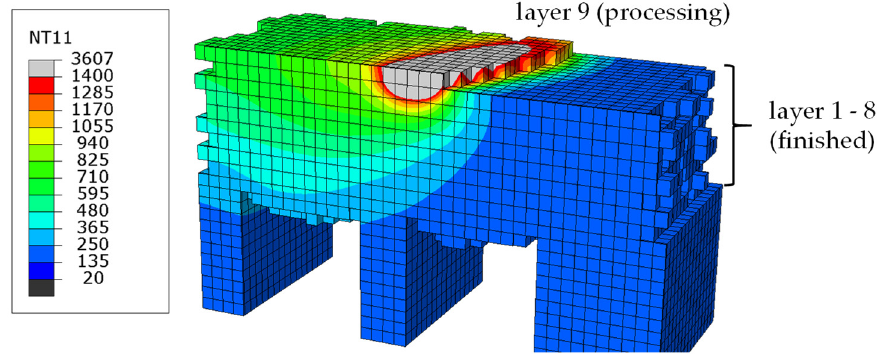
Figure 5. Temperature distribution [°C] around hemispherical heat source—only elements in solid/liquid state are displayed.